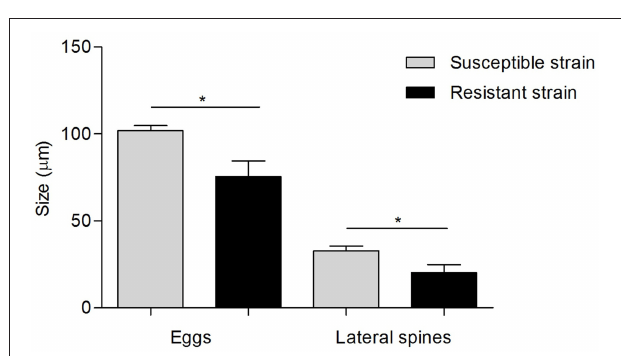
FIGURE 3 | Monitoring of S. mansoni susceptible strain adult worms submitted to 32 µ M of PZQ during 48 h. (A) Adult worms from the susceptible strain exposed to PZQ, showing muscle contraction and reduction of movements; (B) Adult worms from the susceptible strain dead after exposed to PZQ, 24 h after exposure; (C) Adult worms from the susceptible strain not exposed to PZQ (negative control group—susceptible worms kept in RPMI-1640 medium with no addition of the drug); (D) Adult worms from the susceptible strain not exposed to PZQ (negative control group—susceptible worms kept in RPMI-1640 medium with no addition of the drug), 24 h of incubation period.